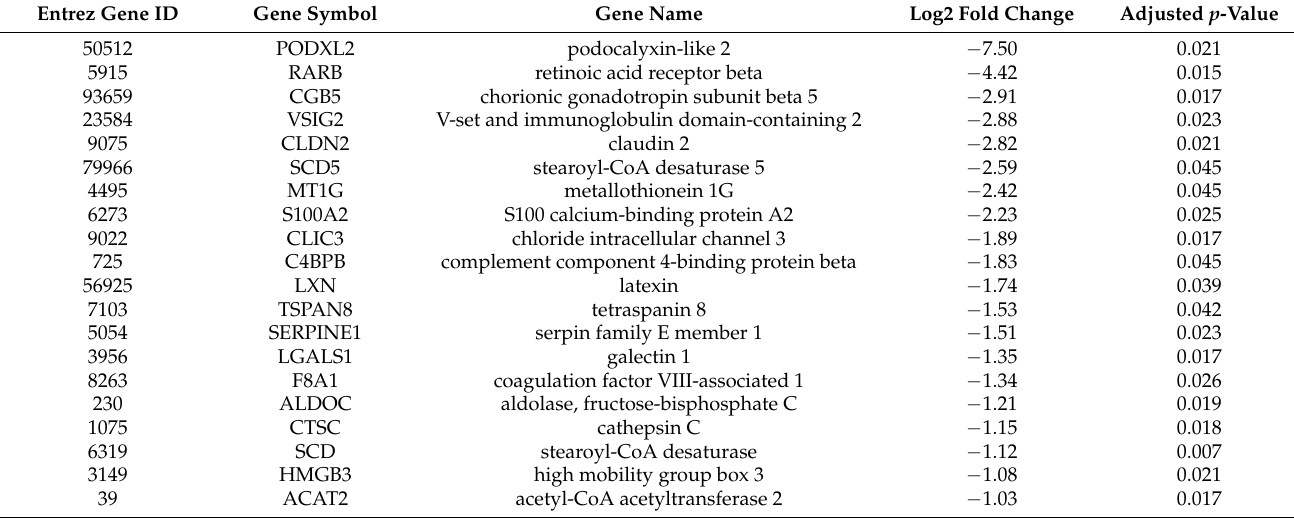
Table 2. Top 20 downregulated genes in ITGB6 -knockout cholangiocarcinoma (HuCCT1) cell line. Entrez Gene